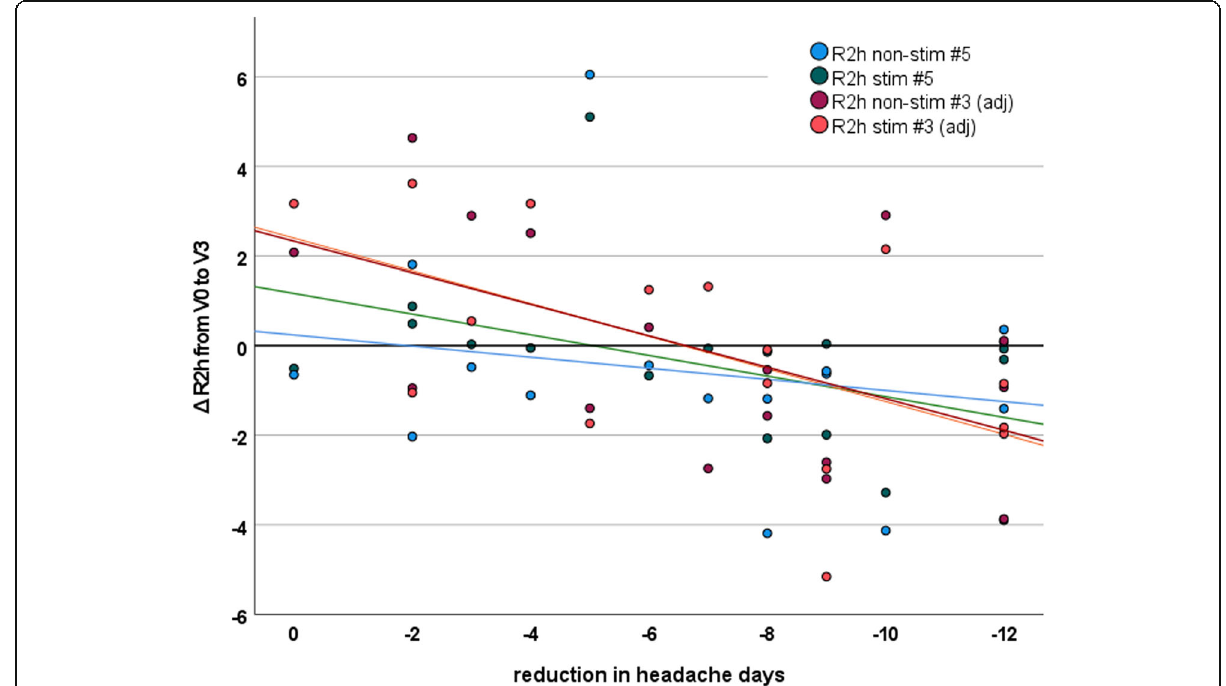
Fig. 4 reduction in headache days as a function of R2h changes after initiation of CGRP mAbs. There is a statistically significant correlation of the change in R2h slope from V0 to V3 on the stimulated and non-stimulated side in blocks three and five. Block three results are adjusted for the time before the next headache attack. Note that the correlation coefficients reported in the results section are by definition standardized while lines plotted here are based on raw